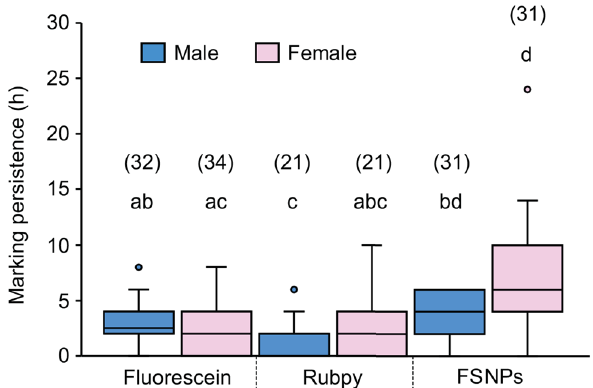
Figure 5. Detectable luminescence duration of Drosophila melanogaster after feeding liquid food containing different markers. The horizontal lines within each box indicate the median, the box edges indicate the 75th and 25th percentiles, the whiskers show the maximum and minimum, and the circles represent outliers. Treatments with a common letter are not significantly different from each other as revealed by the aligned rank test at the 5% level of significance. The numbers above the boxes are the sample size of each treatment.